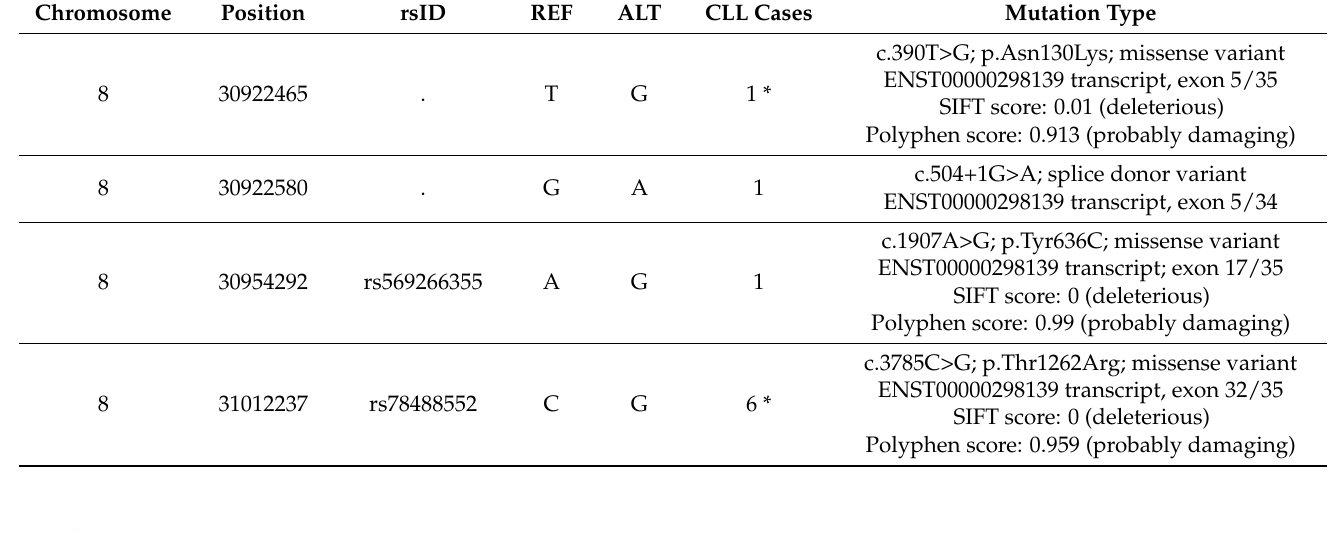
Table 4. Rare and likely functional mutations in WRN among CLL patients. One patient had two concurrent variants (indicated with an asterisk *). Nucleotide and amino acid changes induced by each variant are provided. Chromosome